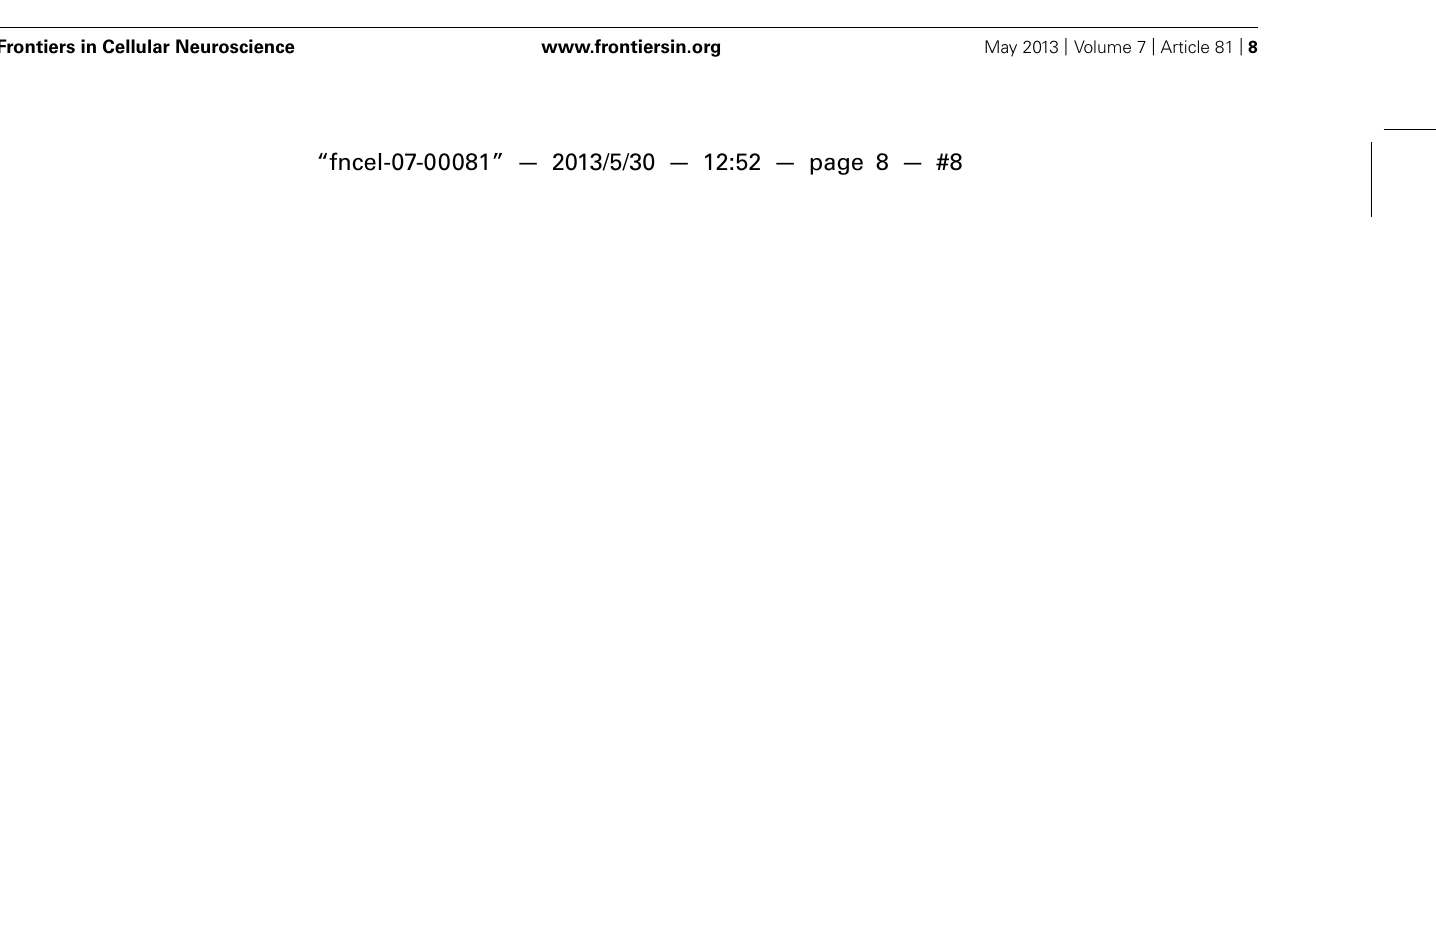
decreases significantly the relative amount of p-mTOR to mTOR and increase that of LC3-II to GAPDH, suggesting an activation of autophagy or accumulation of autophagosomes.These treatments also significantly reduce the level of AA-elicited α -syn oligomer accumulation.The effects of DA or Rapa (data not shown) was blocked/reduced byWM co-treatment indicating that autophagy inhibition counters the effects of DA on reducing α -syn accumulation. (F) Calcein assay showed that Rapa treatment is as effective as DA in protecting cells from AA-elicited cytotoxicity, and thatWM co-treatment reduces the beneficial effects of DA on cell viability. (G) LPO assay showed that Rapa treatment is as effective as DA in lowering LPO, and thatWM co-treatment can reduce the impact of DA on LPO. (* p < 0.05, ** p < 0.01 comparing to Con; # p < 0.05, ## p < 0.01, comparing subsets linked by bracket). Error bars represent